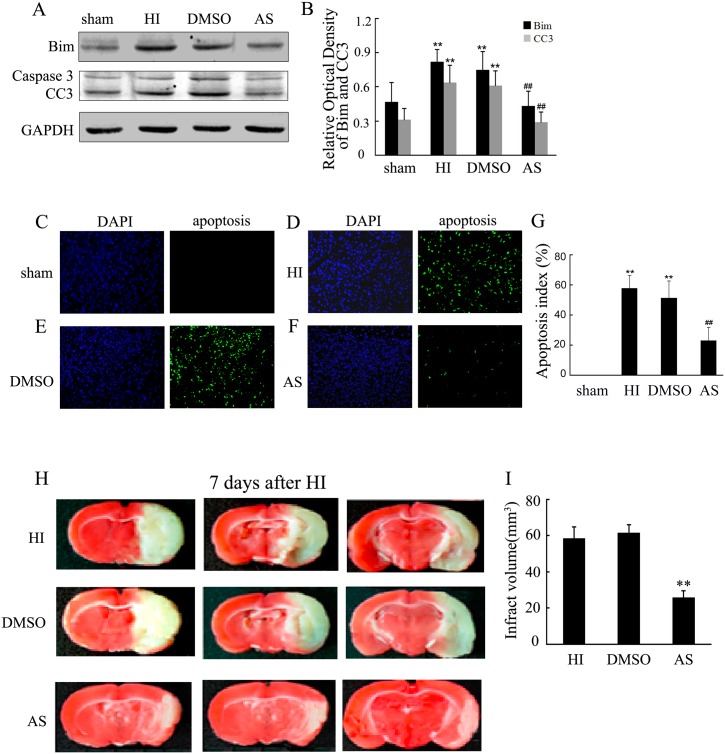
JNK inhibitor AS601245 decreased levels of Bim and CC3 proteins and reduced neuronal apoptosis and brain infarct volume in P7 rat after HI.Samples were obtained from the cortex. Bim and CC3 protein levels were significantly reduced at 48 h in the AS601245-treated cortex compared with the DMSO-treated cortex (A). Cell apoptosis was detected by TUNEL staining with the In Situ Cell Death Detection Kit (Merck Millipore) according to the manufacturer's protocol. Ten fields were chosen randomly at 400x magnification to count the apoptotic and total cells. The apoptotic index (AI) was calculated as follows: AI = (number of apoptotic cells/total number counted) ×100%. TUNEL-positive cells were not detected in the sham controls (C). However, the positive cells were increased at 6 h (data not shown) and 24 h (data not shown) and peaked at 48 h (D) after HI. Meanwhile, AS601245 pretreatment obviously reduced cellular apoptosis at 48 h after HI (F) and decreased the infarct volume 7 days after HI significantly (Fig 4H), compared with the DMSO controls (Fig 4E and 4H,). The cell apoptosis index in the AS601245-treated brain cortex was decreased by 59% compared with the DMSO-treated brain cortex (Fig 4G). The infarct volume in the AS601245-treated brain was decreased by 58% compared with the DMSO controls (Fig 4I).